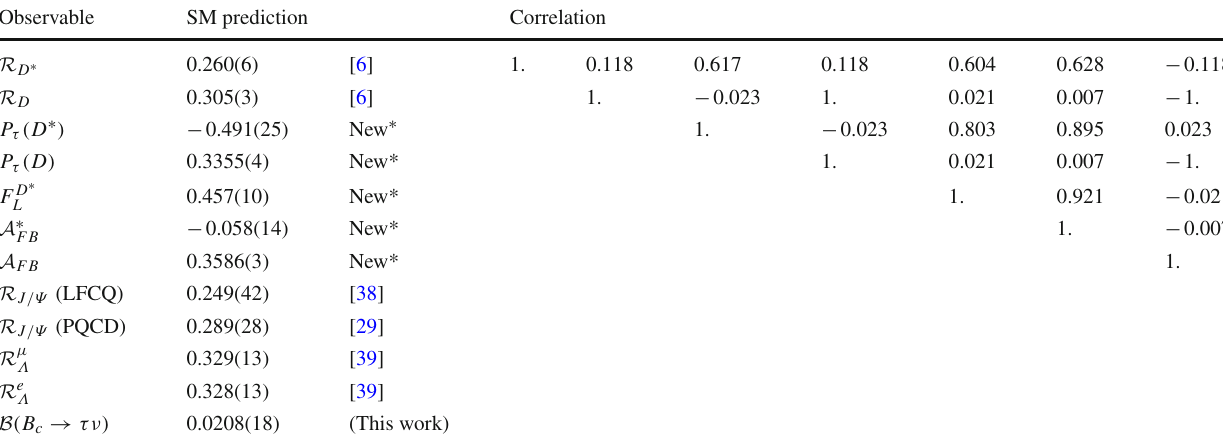
Table 1 SM values of observables obtained and/or used in this paper, with correlations, wherever relevant Observable SM prediction